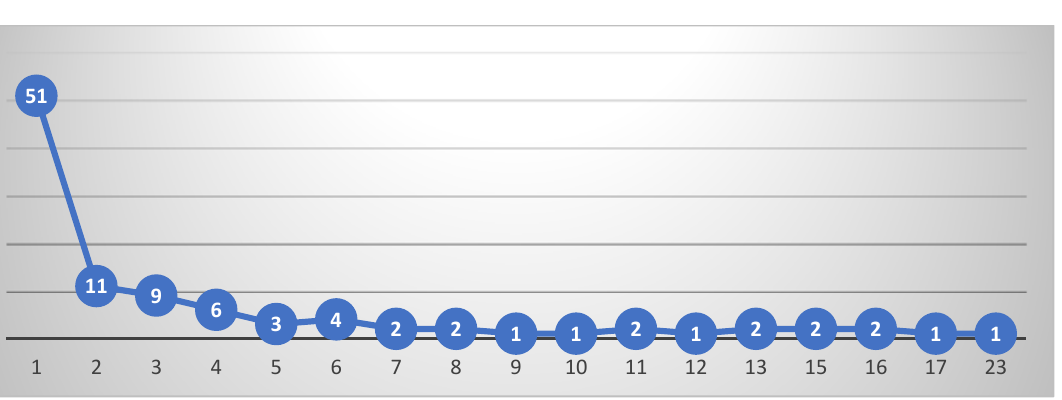
Figure 4. Distribution of attendance over 15 church camps (n = 66). Data shows attendance at biannual church camps fluctuate around 10 to 15 children, of which most attend once or twice before leaving. Of the children who participate, 65% do so between one and two times, with the remaining 35% of children attending between 3 and 13 times (Figure 5). The average number of camps attended was 3.0 camps or roughly 16 months of attendance. Simply put, children do not consecutively attend church school with their overall attendance lasting between one and two years. The percentage of repeating children at the church camp is higher than at church school because the former requires more commitment, including two days of activities, a nominal fee, and preparation. Overall, even children who attended the catechism class monthly and the camp twice a year still had poor attendance leaving shortly after entrance into junior high school. Figure 5. Distribution of Church Camp Attendance (n = 66).